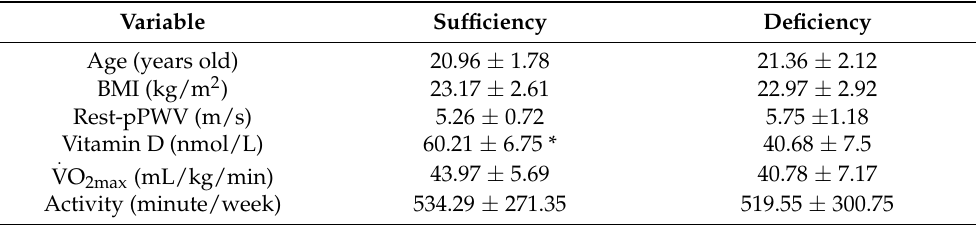
Table 1. Participant